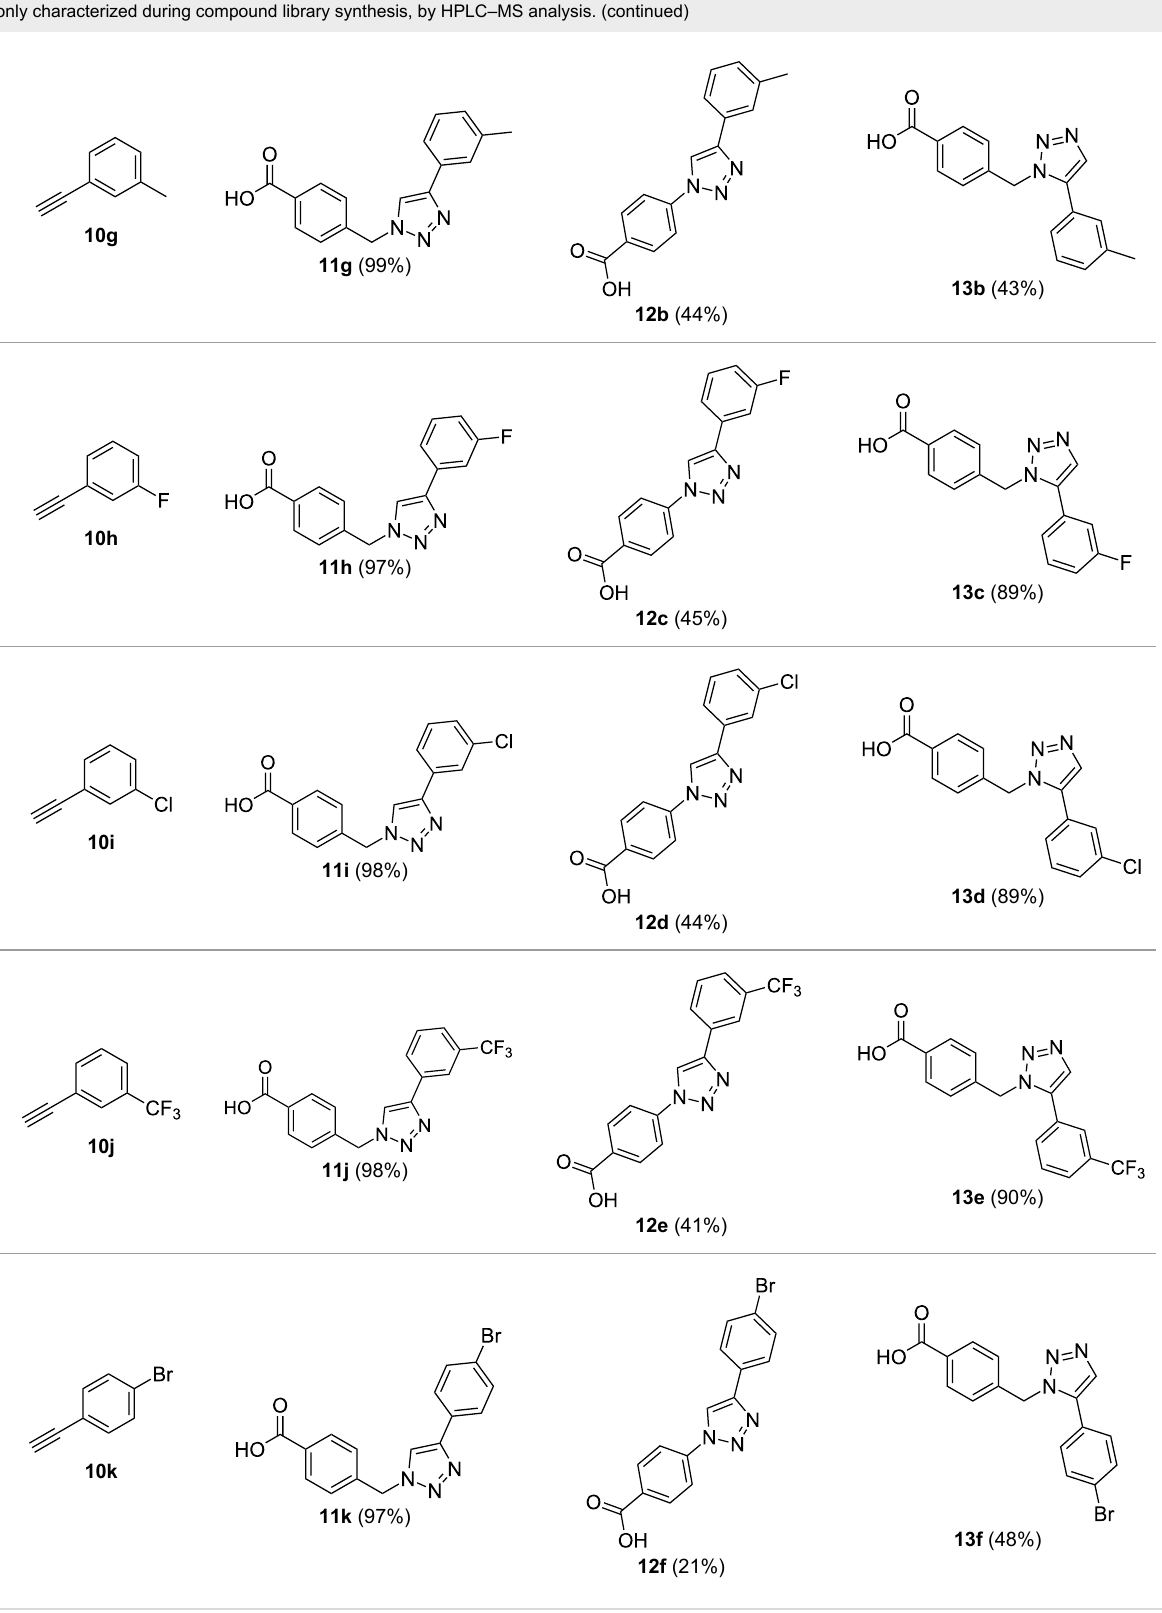
Table 2: Copper-catalyzed [2 + 3] cycloadditions of resin bound azide 7 with five terminal alkynes. Compounds 13 , with the exception of 13f , were only characterized during compound library synthesis, by HPLC–MS analysis.